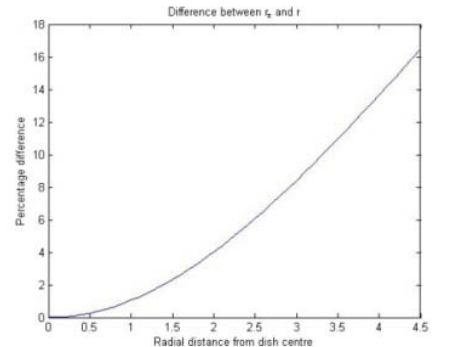
Figure 4: The difference between the algebraic residuals and the approximated orthogonal residuals. The x axis is the radial distance of the point to the centre of the dish and the y axis is the percentage difference between r (z) and r (a) .